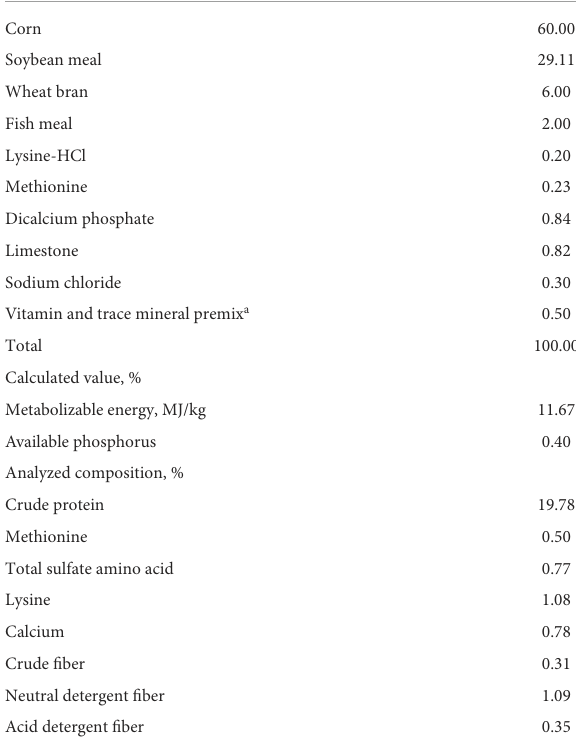
TABLE 1 Composition and nutrient levels of the experimental basal diet (%, as-fed basis). Ingredients,